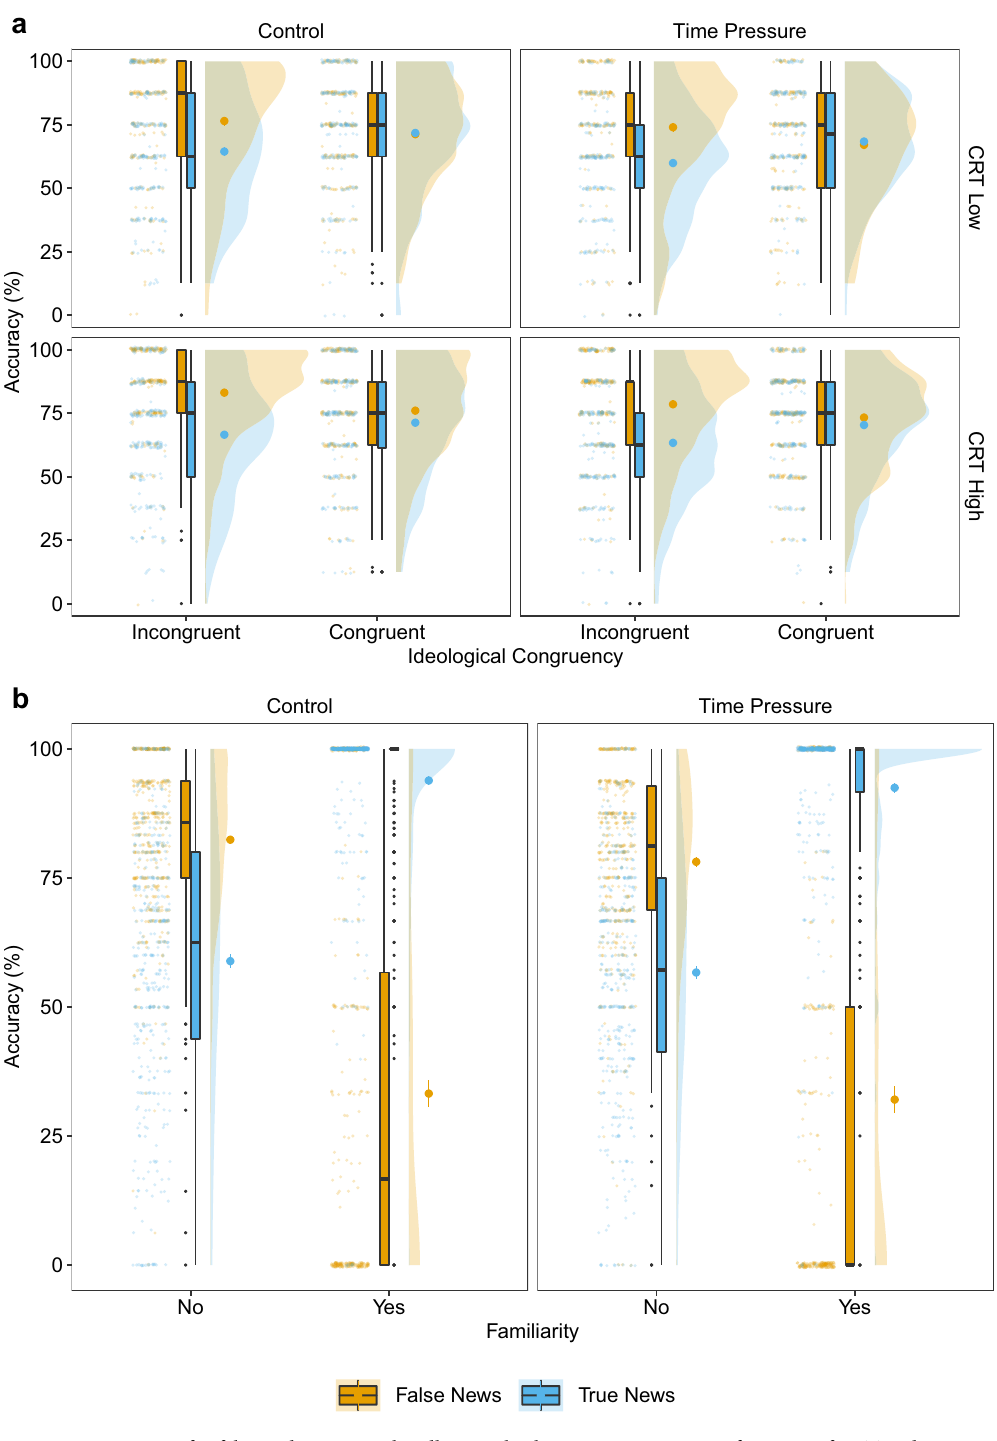
Figure 5. Accuracy for false and true news headlines in both time treatments as a function of CRT and ideological congruency ( a ) and familiarity ( b ). The small coloured dots represent the mean accuracy of each individual. The boxplots show the median value and the IQR. The whiskers indicate an additional 1.5 IQR and the small black dots represent outliers. The large coloured dots represent the aggregate mean with standard errors. The density plots describe the distribution of the